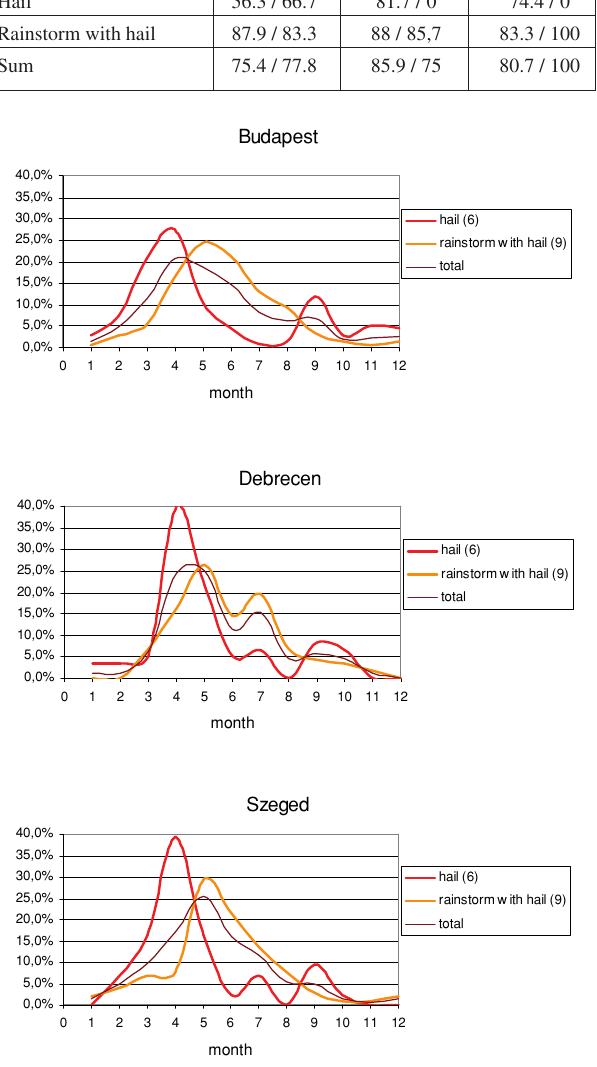
Figure 3: Monthly distribution of hail events (1901–2000)